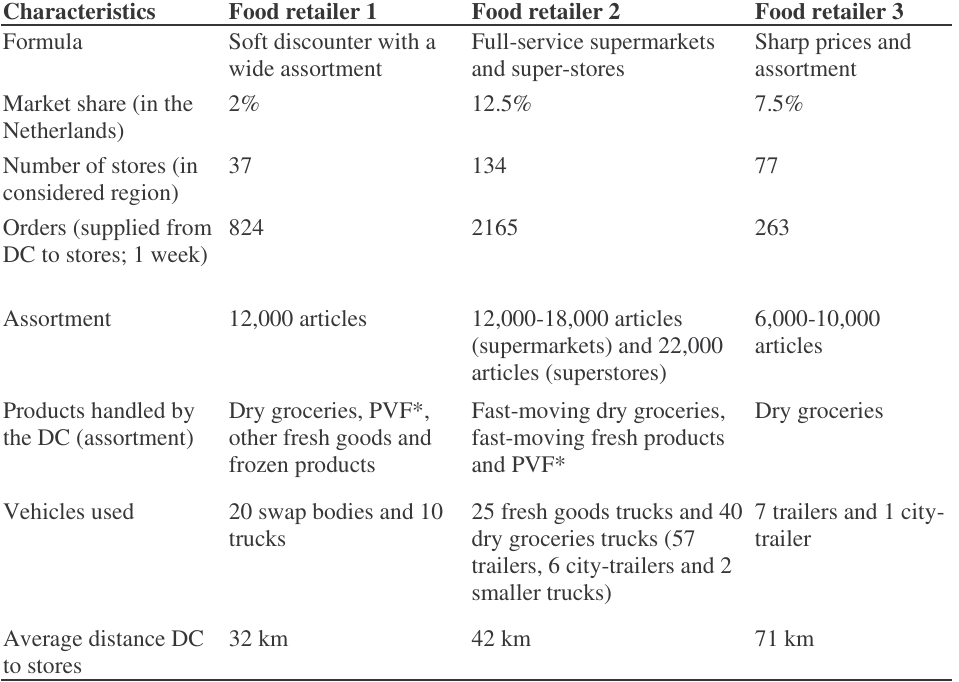
Table 1. Retailers’